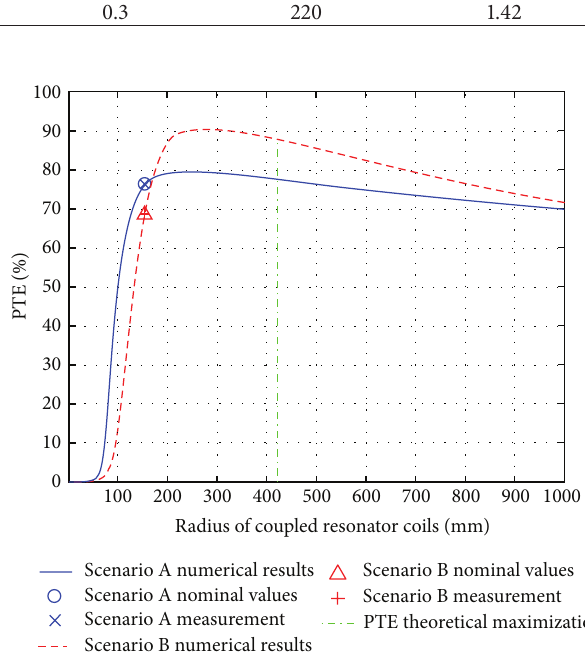
Figure 3: PTE versus coupled resonator coil radius for two different DCR configuration